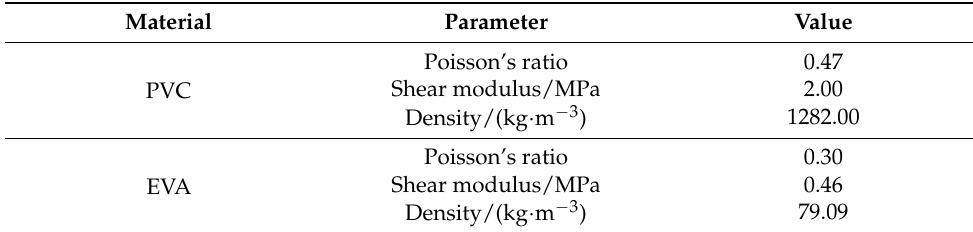
Table 2. Simulation parameters of contact materials.